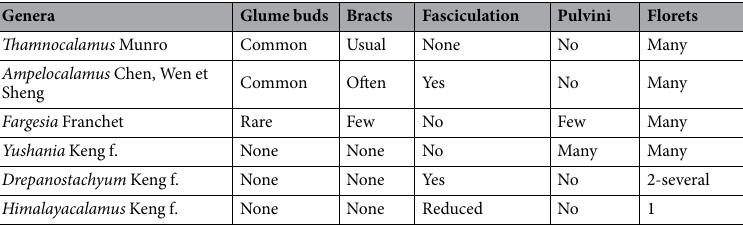
Table 4. Feature comparison of the inflorescences of representatives of the genera in the Thamnocalamus group.